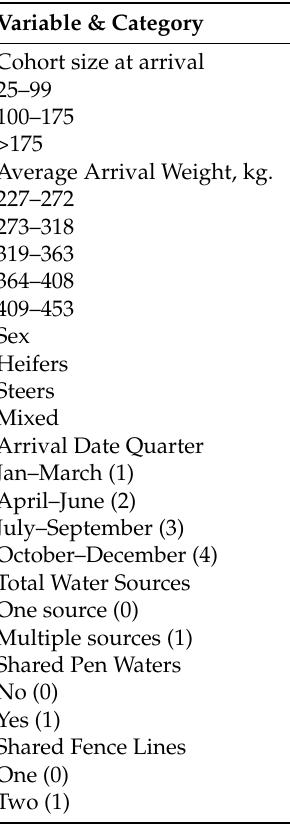
Table 1. Distribution of variables used for analysis from 10 United States feedlots from January